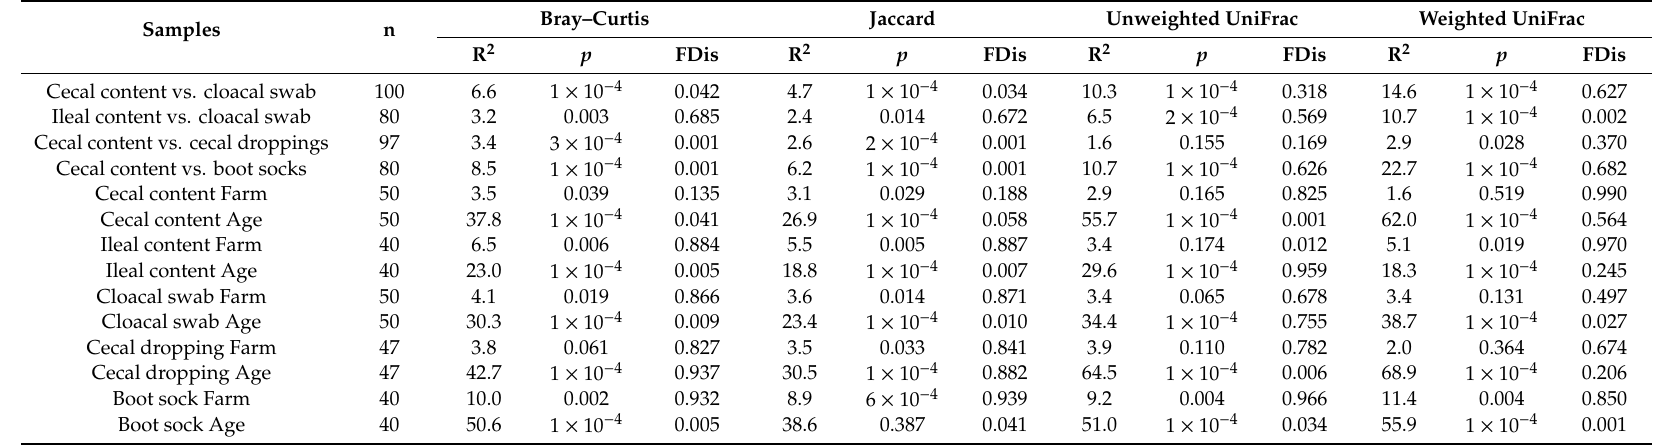
Table 2. Beta diversity analysis across di ff erent samples types. Overview of di ff erent distance measures that determine the microbiota interindividual diversity, R 2 = Percentage of the variation between broilers explained, p = p -value permutational analysis of variance (PERMANOVA) test, FDis = p -value multivariate dispersions